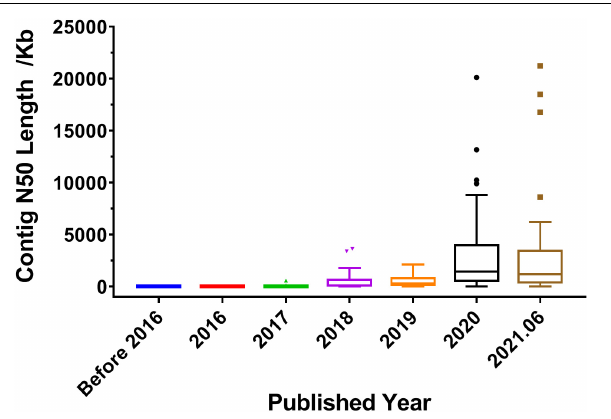
FIGURE 3 | Distribution of contig N50 length in published medicinal plant genomes. Before 2016 represents the published years before 2016, and 2021.06 represents the time between 2021 January and